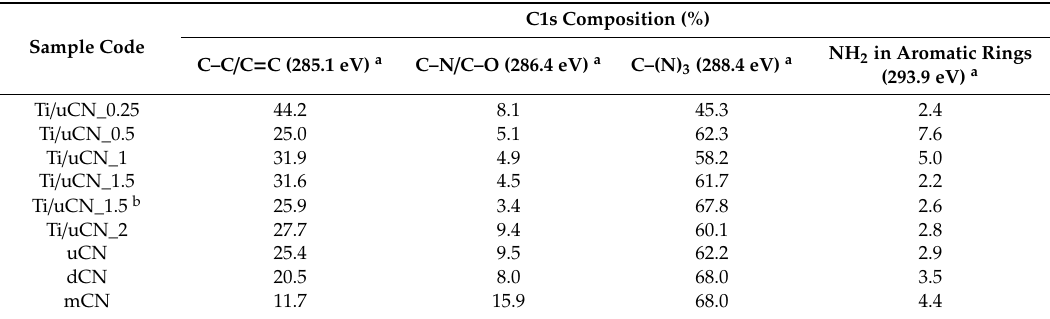
Table 2. Surface composition of carbon-contained functional groups based on XPS C1s fitting results.